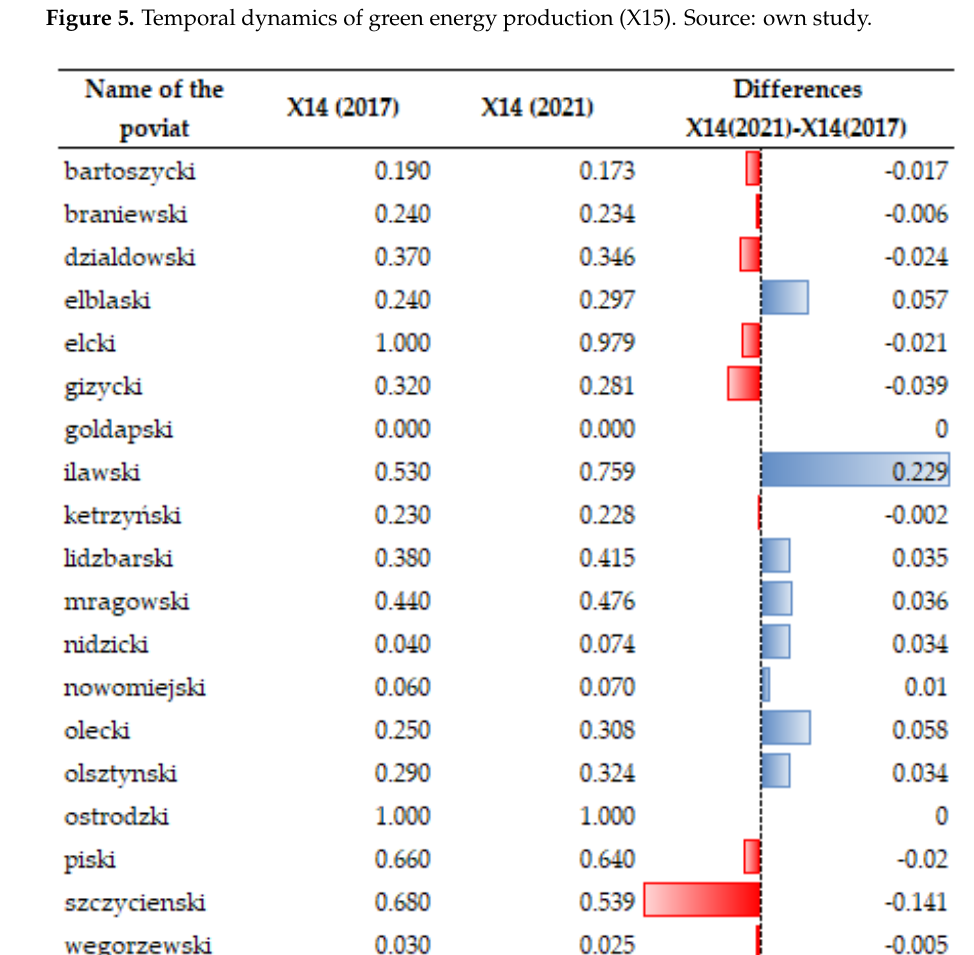
Figure 6. Changes in the index of greenhouse gas emissions (X14) in individual spatial units (tons/per year). Source: own study on [104].